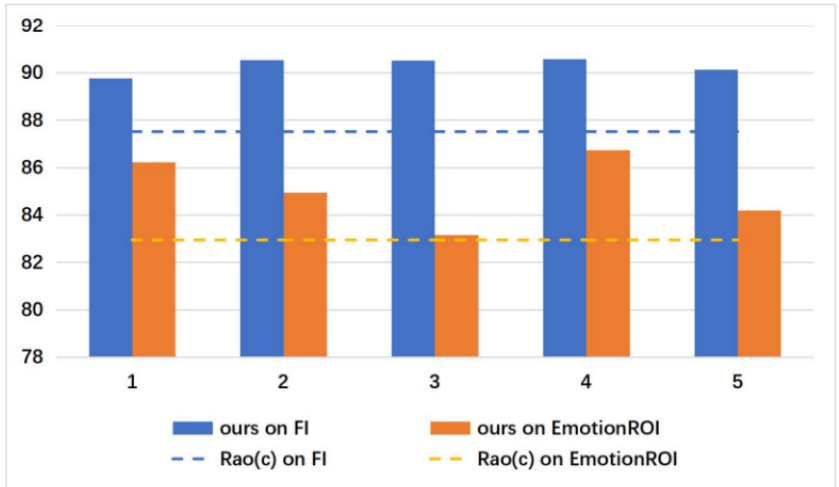
Figure 9. The results of our method on 5-fold cross validation on FI and EMotionROI. The final results are compared with the Rao (c)’s method, which has the highest accuracy presently. Table 4. Classification results of different state-of-the-art methods on twitter I and twitter II. The bold score is the highest score of each column.